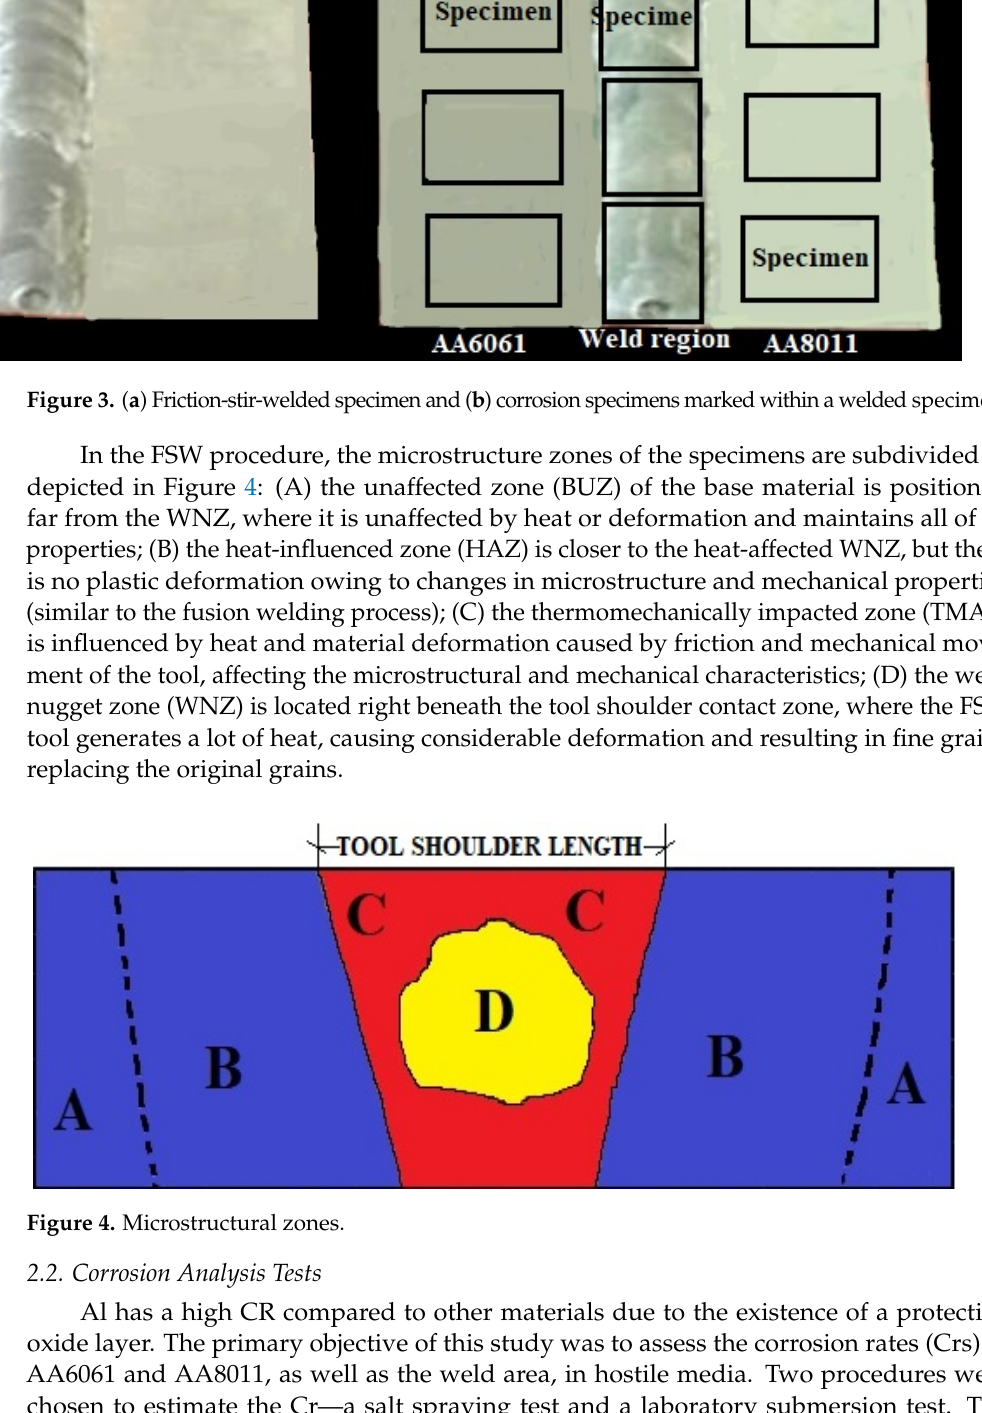
Figure 4. Microstructural zones.